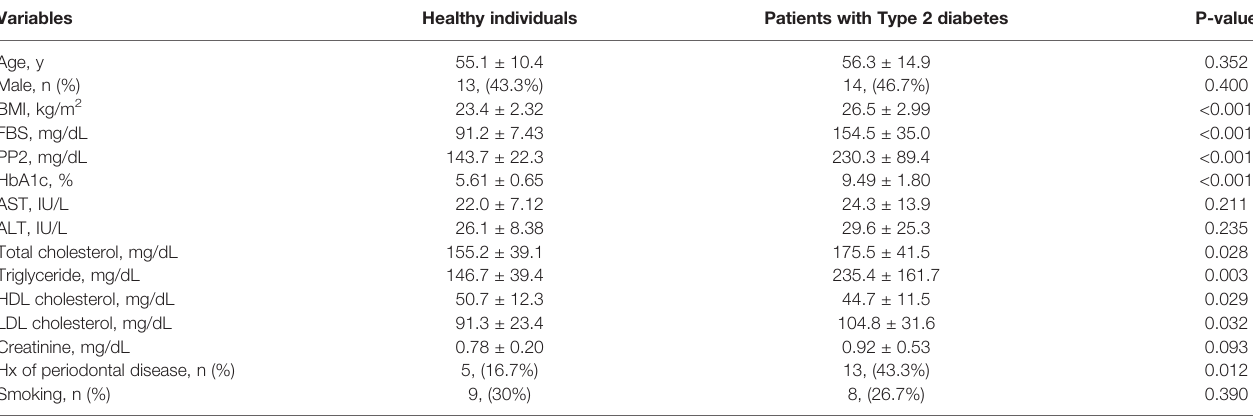
TABLE 1 | Clinical characteristics and serum chemistry of the study population. Variables